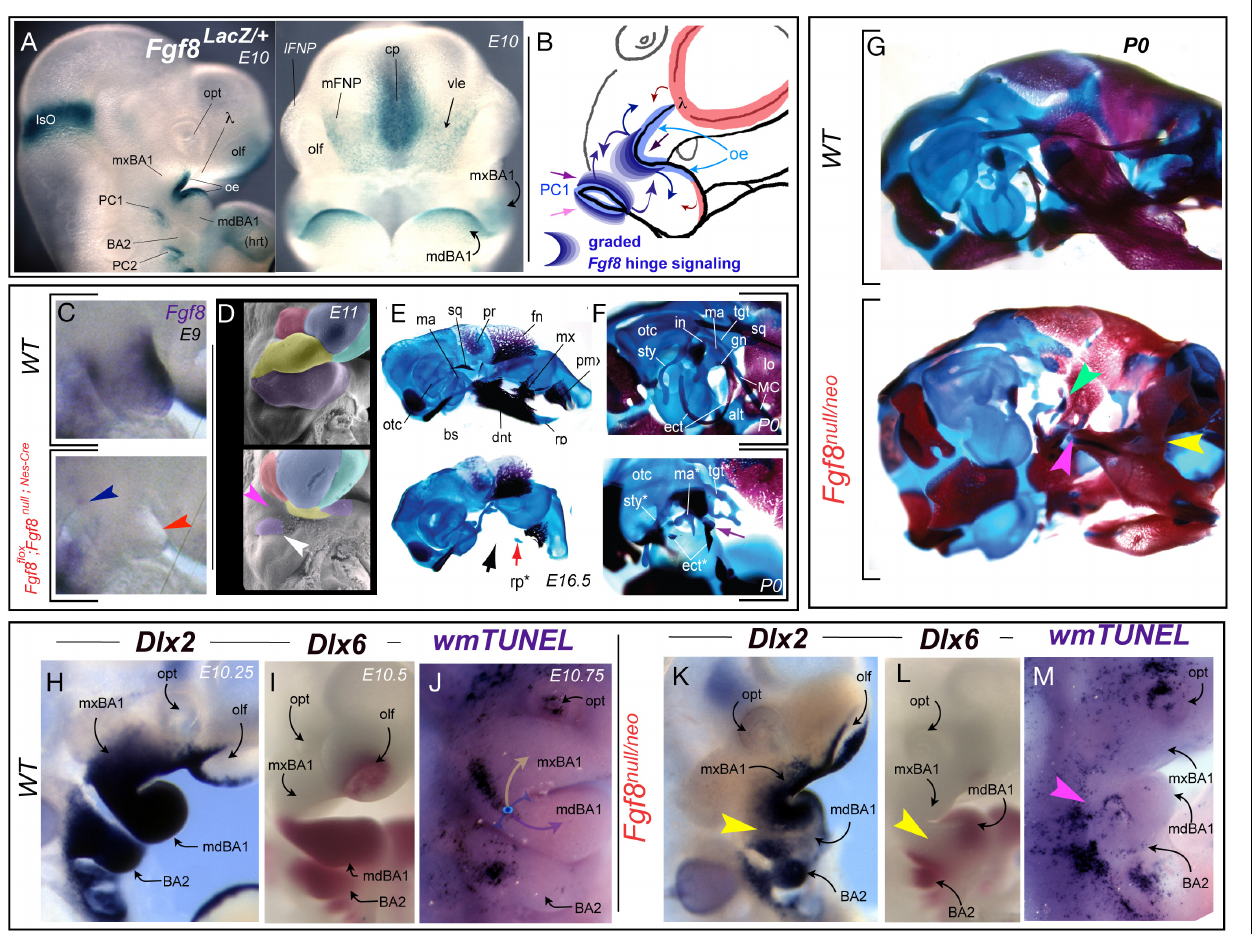
FIGURE 5 | Fgf8 , apoptosis, and developmental integration at the hinge. (A) Fgf8 expression, notable in the oral ectoderm (oe) and pharyngeal cleft (PC1) as assayed by X-gal staining due to β -galactosidase activity resulting from the insertion of a LacZ cassette in the Fgf8 locus. (B) Schema depicting the graded Fgf8 signaling environment that the BA1 CNC must interpret at the hinge. (C–F) Tissue specific inactivation of Fgf8 in the oral ectoderm and pharyngeal cleft. (C) Fgf8 expression at E9 demonstrating (red arrowhead) that the gene has been inactivated in the oral ectoderm of BA1. Blue arrowhead, slight persistent PC1 expression. (D) Psuedocoloured scanning electron micrographs of wild type and Fgf8 flox ; Fgf8 null ; Nes − Cre E11 embryos. White arrowhead, mdBA1 tissue associated with the developing malleus. Magenta arrowhead, catastrophic loss of most of the BA1 primordia. (E–G) Differential staining of bone (red) and cartilage (blue) in E16 (E) and P0 (F) wild type and Fgf8 flox ;Fgf8 null ; Nes − Cre embryos. Black arrow, devastating loss of hinge-associated structure. Red arrow, remnants of the mdBA1 cap associated rostral process (rp). Purple arrow, the remnants of the ectotympanic (etc) and malleus (ma). (G) Genetic attenuation of Fgf8 demonstrating the disintegration of hinge structures. Yellow arrowhead, dentary-maxillary synganthia. Magenta arrowhead, loss of the lower jaw articulation structures. Green, malleo-ectotympanic tissue. (H–M) Topography of altered gene expression and apoptosis in E10.25–10.75 mouse embryos. (H,K) Dlx2 expression. Yellow arrowhead in K, separation in oral and aboral domains due to decreased Fgf8 levels across the huge region. (I,L) Dlx6 expression. Yellow arrowhead in L, separation in oral and aboral domains due to decreased Fgf8 levels. (J,M) Alterations of apoptotic topography, including loss of normal mxBA1 apoptotic swath (magenta